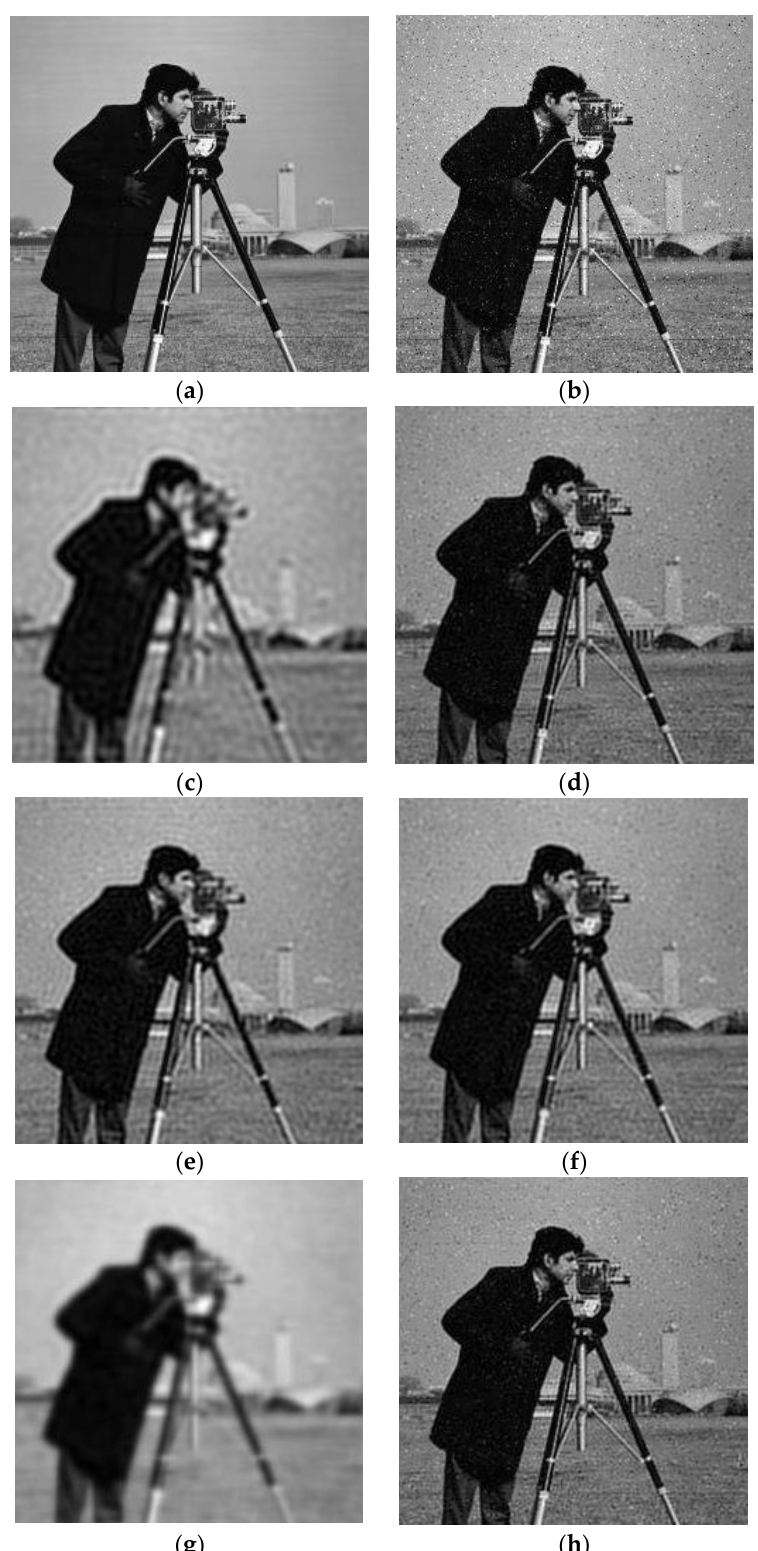
Figure 5. Visual comparison of the different designed filters with a wider bandwidth. ( a ) Original image, ( b ) corrupted image, ( c ) filtering with PSO, ( d ) filtering with ABC, ( e ) filtering with DE, ( f ) filtering with HS, ( g ) filtering with GSA and ( h ) filtering with FPA.